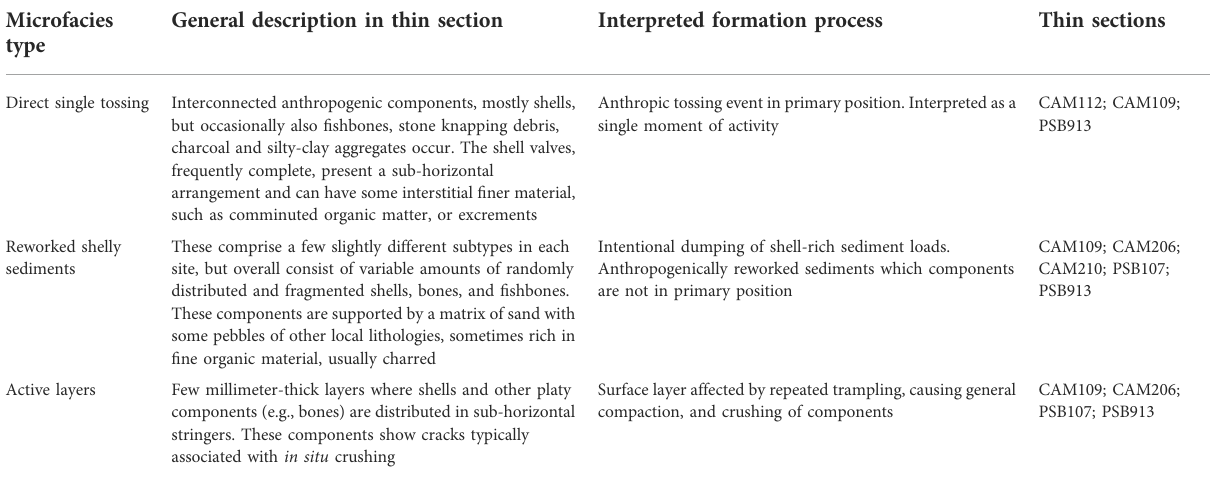
TABLE 2 Types of sedimentary microfacies identi fi ed in Cabeço da Amoreira and Poças de São Bento shell middens used in this